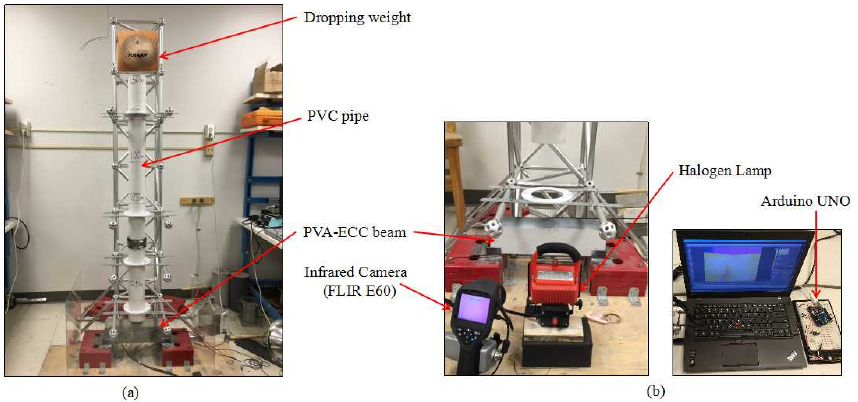
Figure 2. Impact experimental setup ( a ) test setup; ( b ) data acquisition system. (PVC: polyvinyl chloride; PVA ‐ ECC: polyvinyl alcohol fiber reinforced engineering cementitious composite).